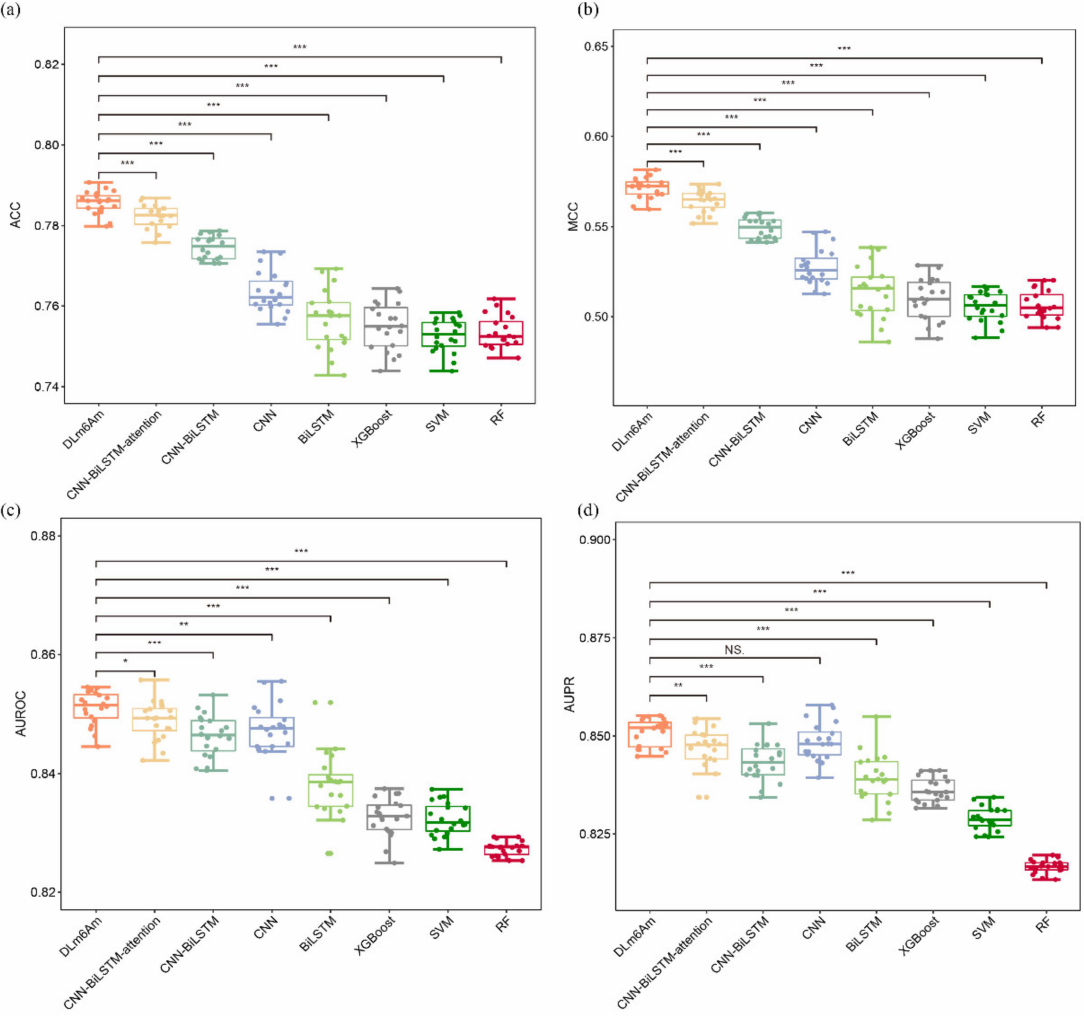
Figure 3. Performance analysis of different m 6 Am prediction models using five-fold cross-validation on training data. Subgraphs ( a – d ) represent boxplots of ACC, MCC, AUROC, and AUPR of different models, respectively. The level of significance (NS, *, **, ***) represents non-significant ( p > 0.05), low significance ( p < 0.05), medium significance ( p < 0.01), and high significance ( p < 0.001),